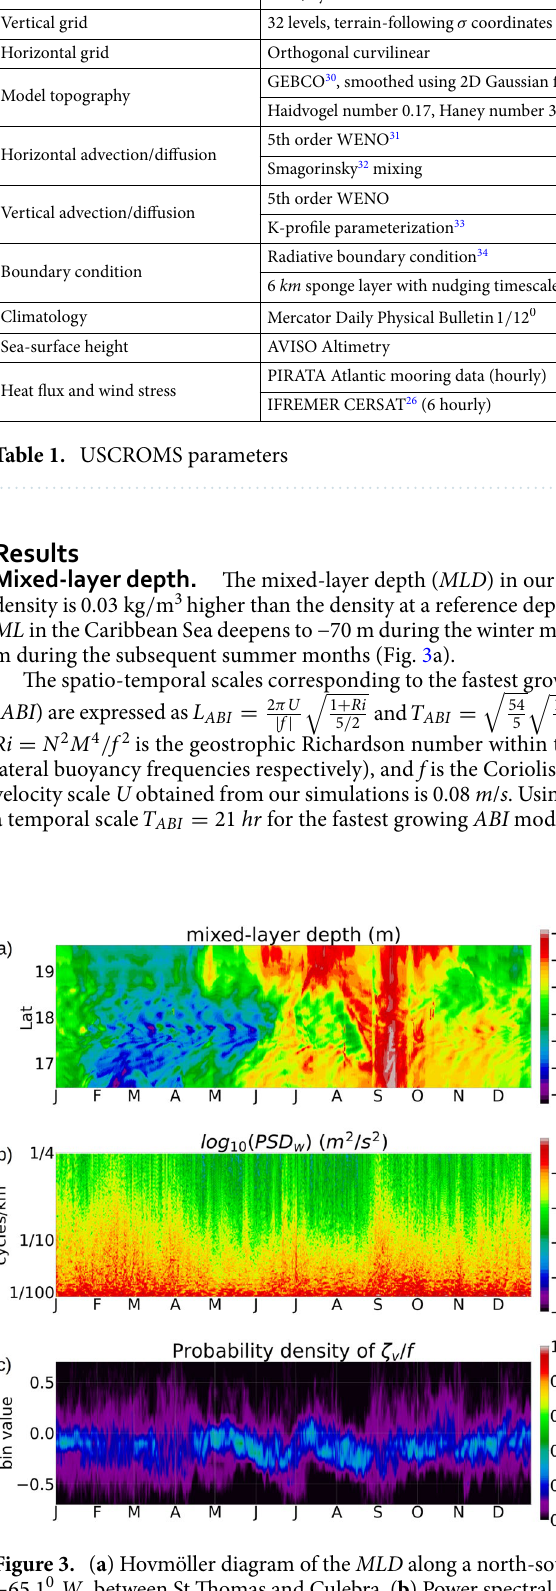
0 W . ( c ) Probability density of the